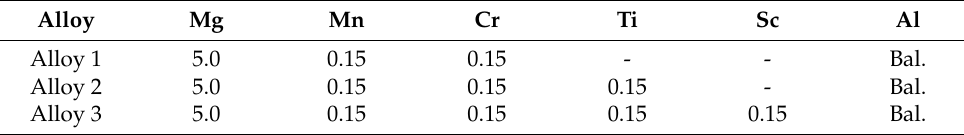
Table 1. Chemical compositions of the Al-Mg alloy designed with different compositions (wt.%). Alloy Mg Mn Cr Ti Sc Al Alloy 1 5.0 0.15 0.15 - - Bal. Alloy 2 5.0 0.15 0.15 0.15 - Bal. Alloy 3 5.0 0.15 0.15 0.15 0.15